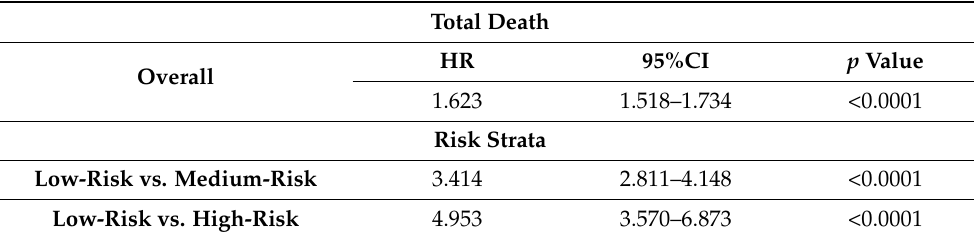
Table 6. The total all-cause-death Hazard Ratios for C 2 HEST risk stratification in non-HF